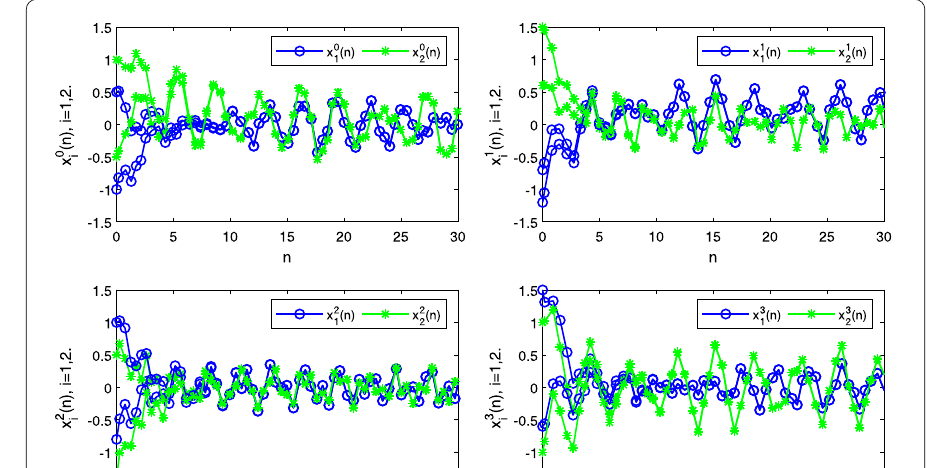
Figures 7 and 9 have the same initial